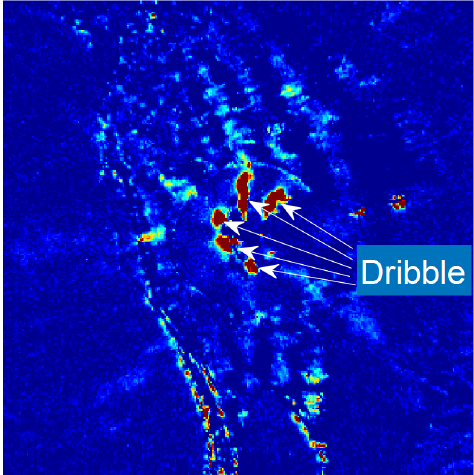
Figure 9. Near nozzle area right after the first pilot injection when the new injector is used, with contrast enhancing.